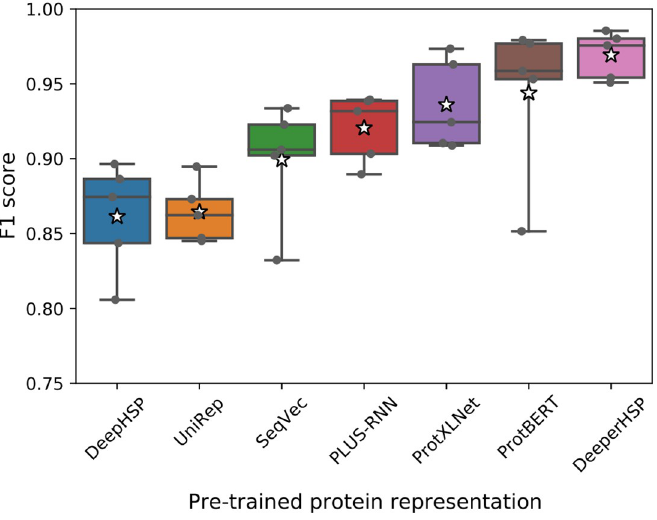
Fig 5. Boxplot of the F1 scores obtained from DeeperHSP with different pre-trained protein representations using 5-fold cross-validation.